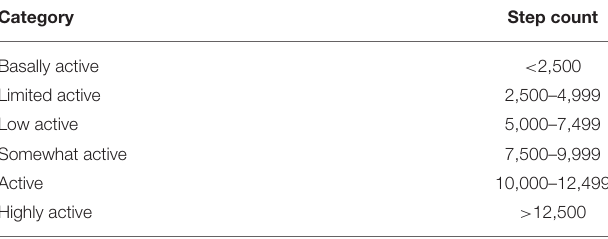
TABLE 1 | Physical activity categories according to step